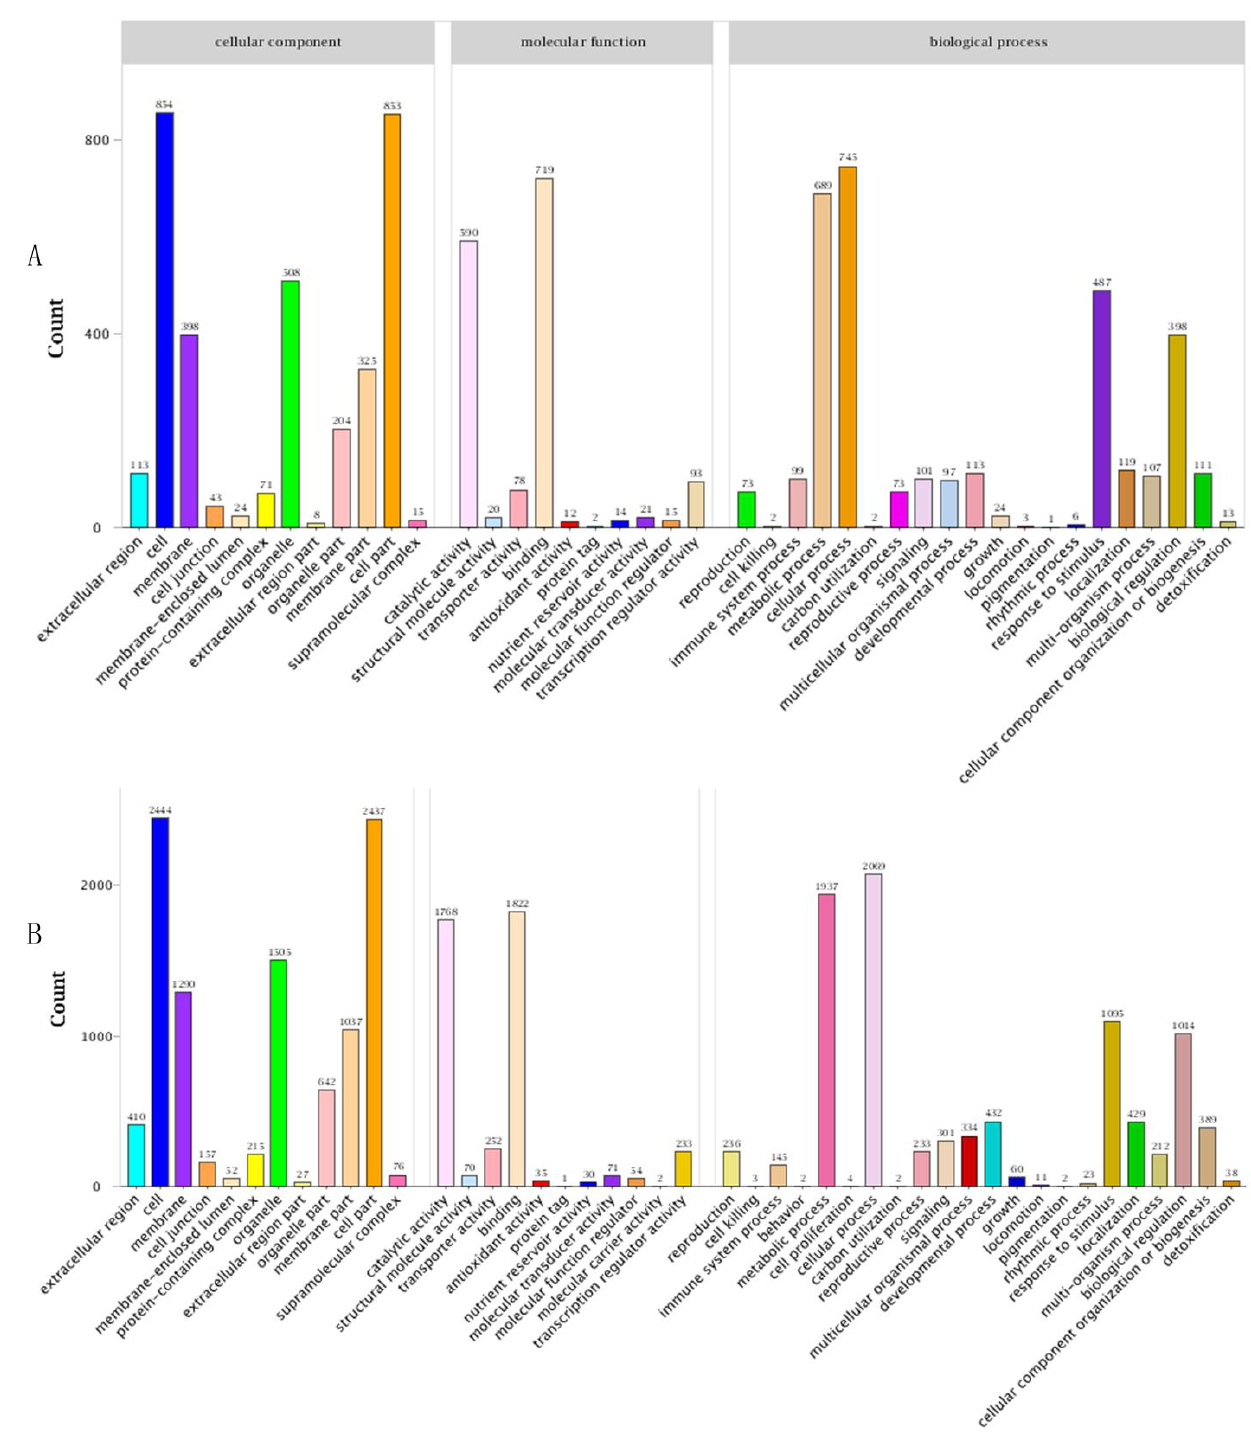
Figure 7. GO classification of DEGs during the growth period of weeping peach branches: ( A ) comparison of HCZ and XH at the early stage of branch growth (HCZS1 vs. XHS1); ( B ) comparison of HCZ and XH at the late stage of branch growth (HCZS2 vs. XHS2). HCZ—weeping peach ‘Hongchuizhi’ variety; XH—standard peach ‘Xiahui 6 ’ variety.